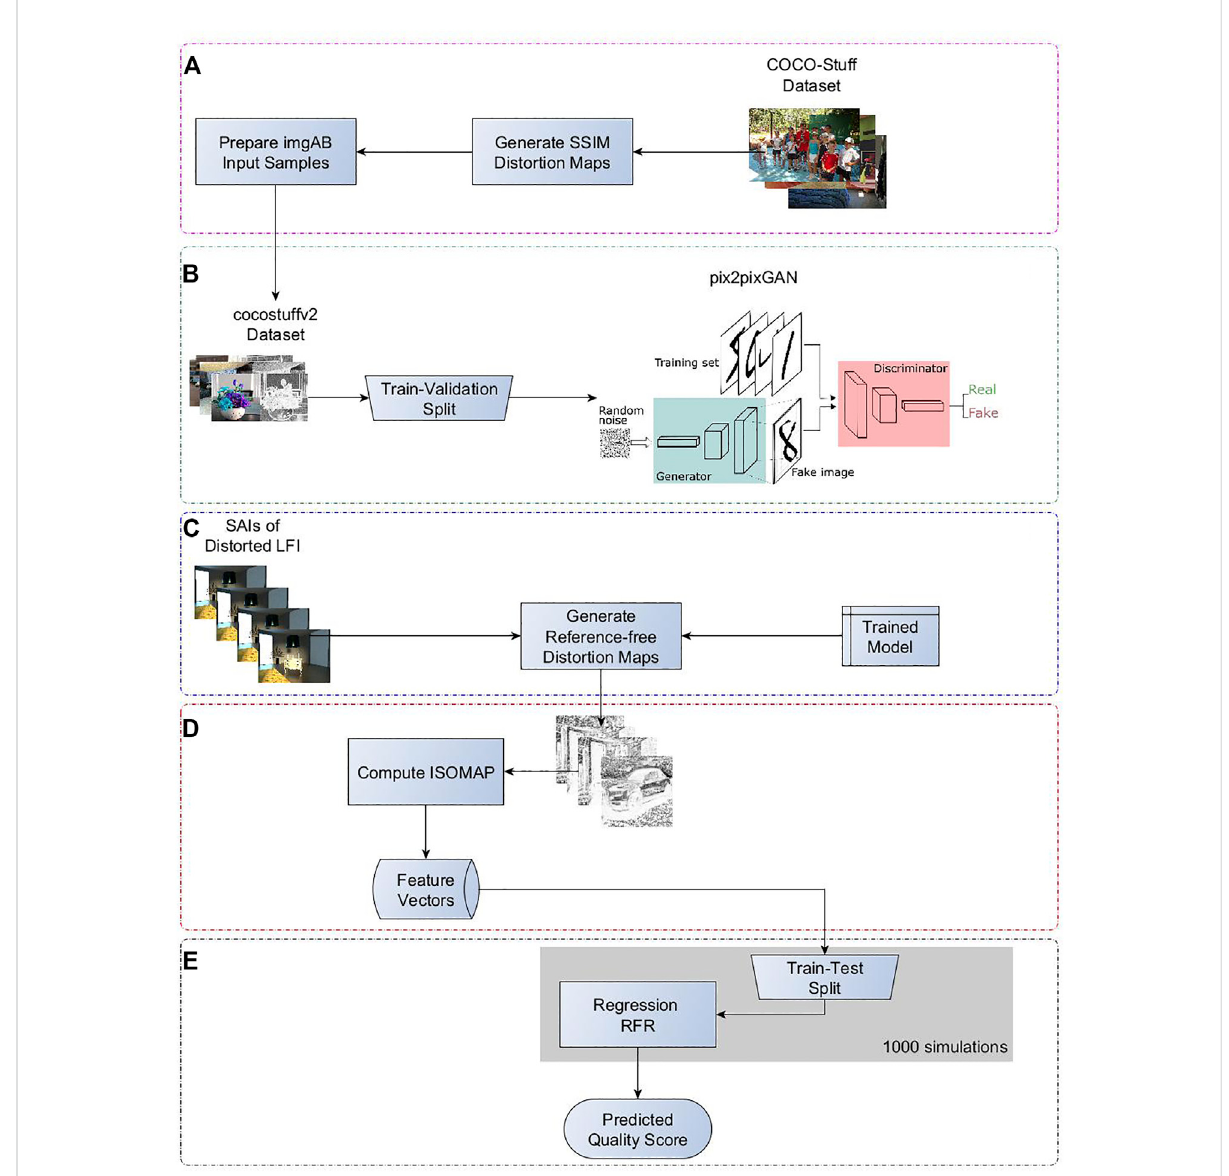
FIGURE 2 Block Diagram of the proposed no-reference light fi eld image quality assessment method. (A) computation of SSIM distortion maps corresponding to the original and test images, (B) training the GAN network using the SSIM distortion maps as labels, (C) testing the trained GAN network to generate reference-free distortion maps of sub-aperture images of test LFIs, (D) computation of ISOMAP to generate feature vectors for distortion maps generated in (C) , and (E) training Random Forest Regressor with 1000 simulations for quality